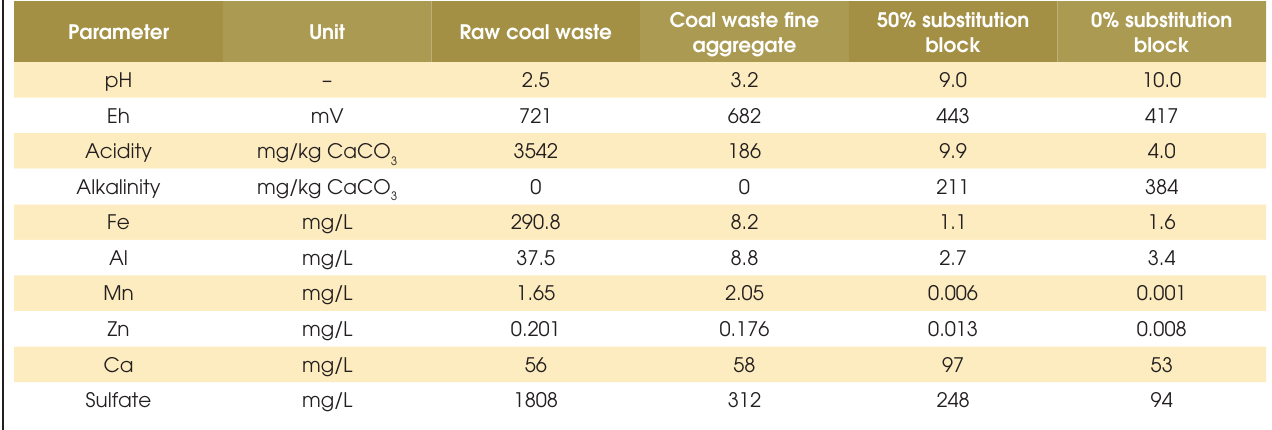
Table 5 – Average values of parameters analyzed along the kinetic test in humidity cells (n=20)